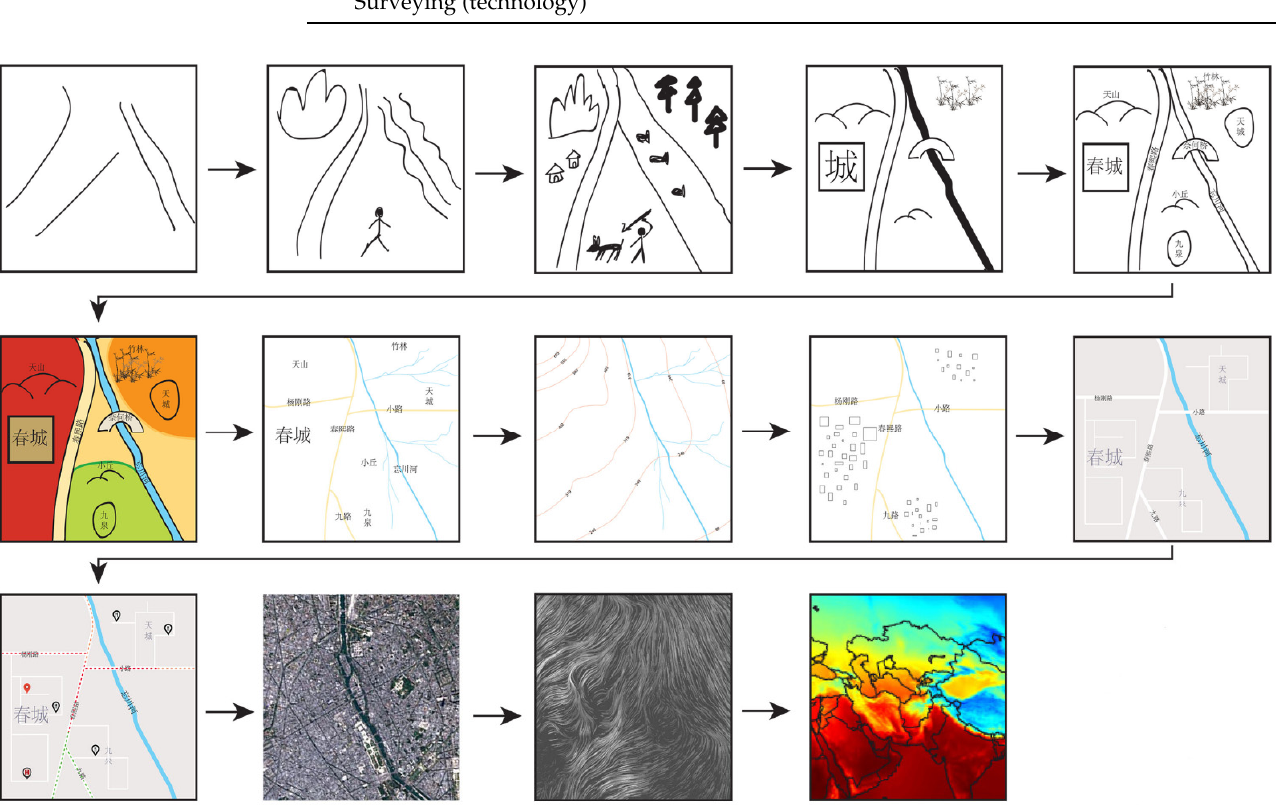
Figure 1. An example of results of a reflective mapping exercise.